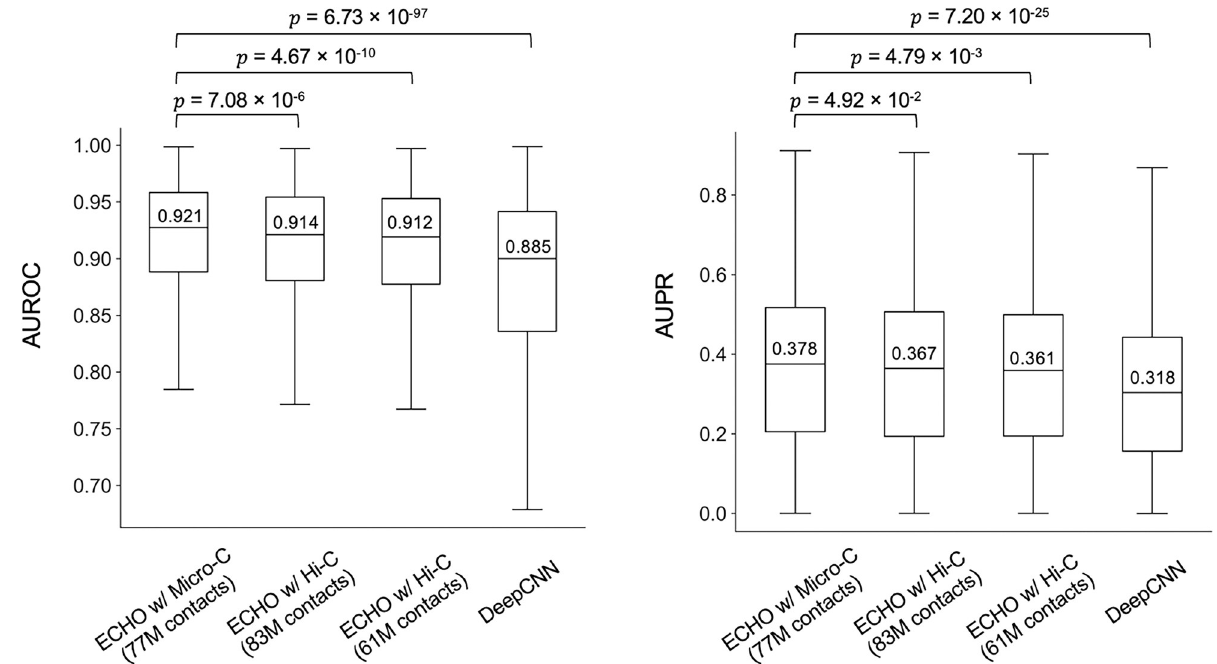
Fig 3. ECHO’s performance when it is coupled with different types of contact maps. Two types of contact maps (200-bp Micro-C contact maps and up-sampled 200-bp Hi-C contact maps) are compared here. The p -values from paired t -tests indicate that Micro-C contact maps provide more precise high resolution chromatin contact information for chromatin feature prediction. The x-axis shows the contact map types and the total numbers of chromatin contacts used by ECHO (resulting from two contact value cut-off thresholds). The median AUROC and AUPR scores are provided above the median